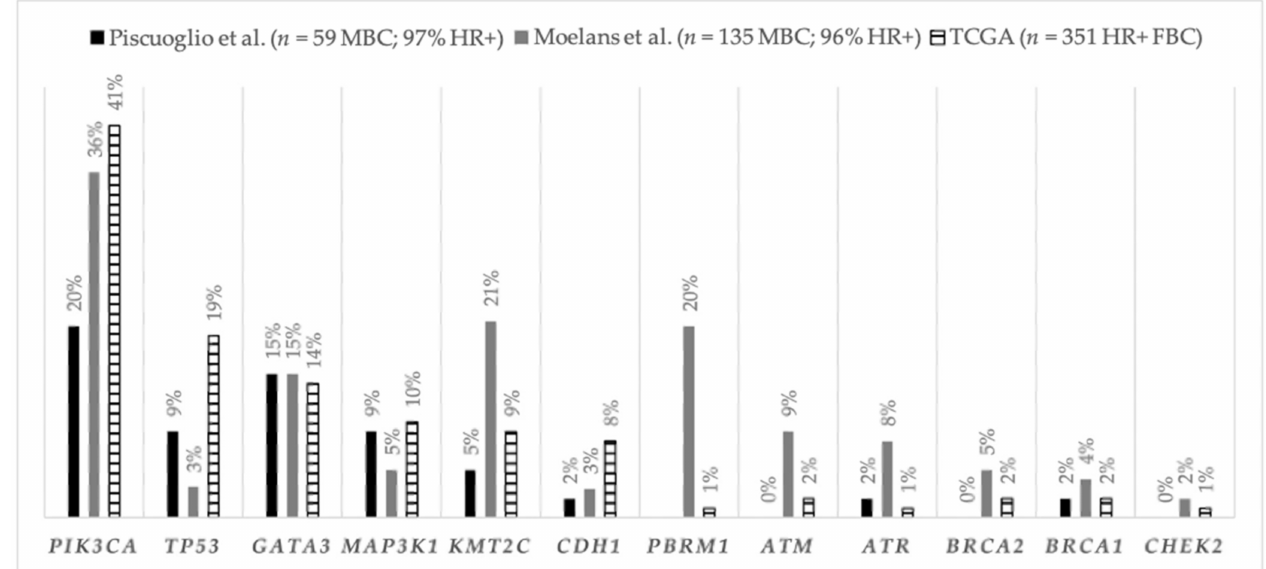
Figure 1. Frequency of the altered genes in luminal tumors from MBC and from breast cancer TCGA samples. First are percentages of the most common altered genes in the studies. Last are presented the frequencies of the most common altered DNA repair-related genes, besides TP53 , which include ATM , ATR , BRCA2 , BRCA1 , and CHEK2